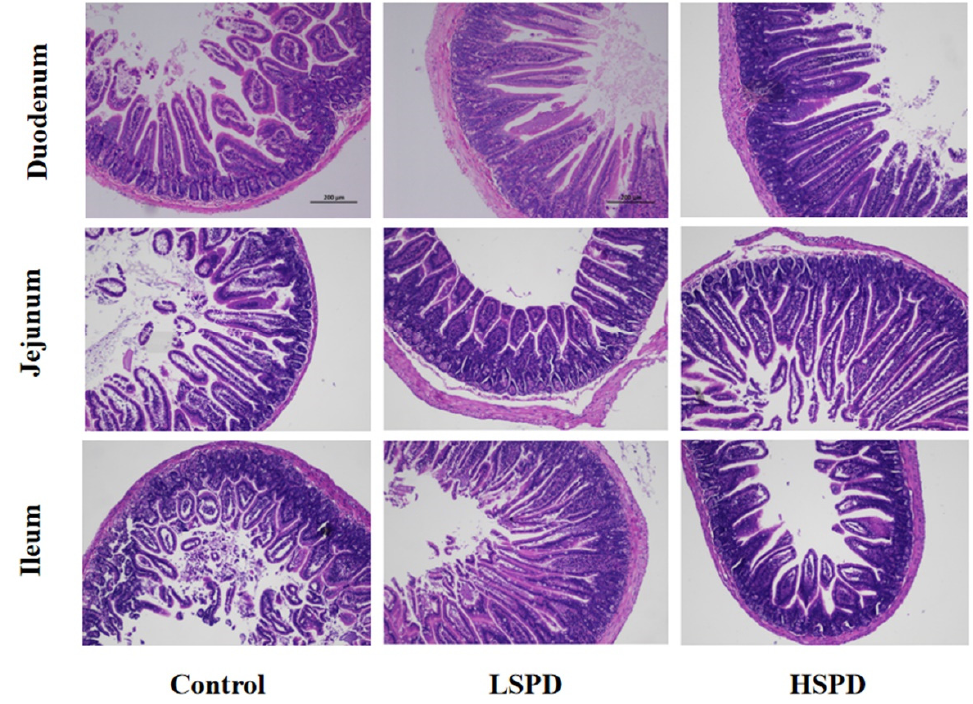
Figure 1. Effect of spermidine on mouse weight gain and final body weight of the mice. ( A ) Evo-